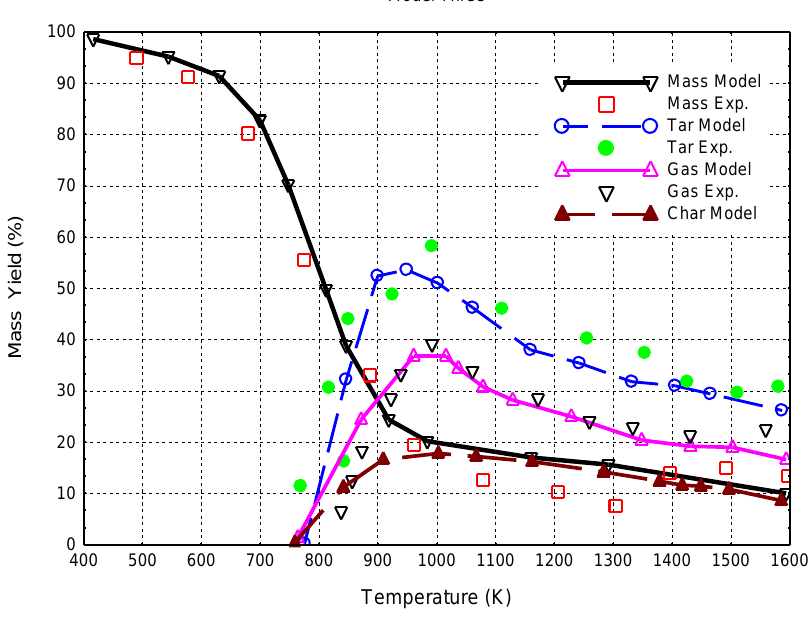
Figure 5. Simulations of gasification and/or devolatilization model 3 (M3) and experimental measurements (using Nunn et al. [50]) for a mass yield of gases, char, and tar of powder biomass at fast heating rate conditions in combustion engines.